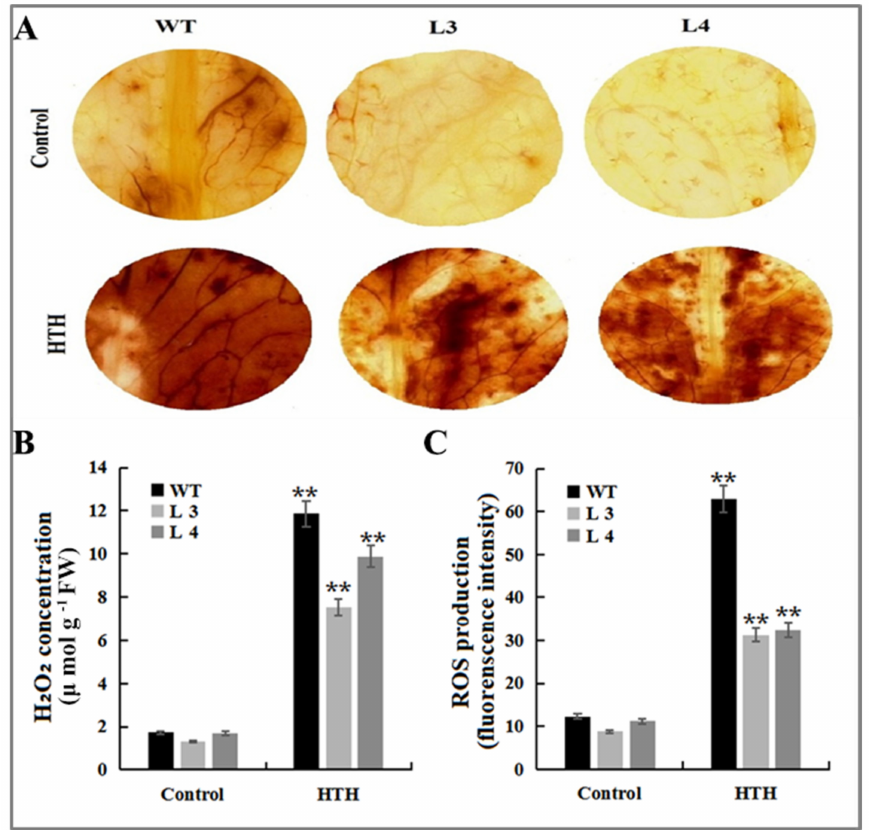
Figure 6. Interactive effects of high temperature and high humidity on ( A ) accumulation of hydro- gen peroxide, ( B ) hydrogen peroxide content, ( C ) accumulation of superoxide anion. ** denotes significance at p < 0.01 level, according to Tukey’s correction ( p <